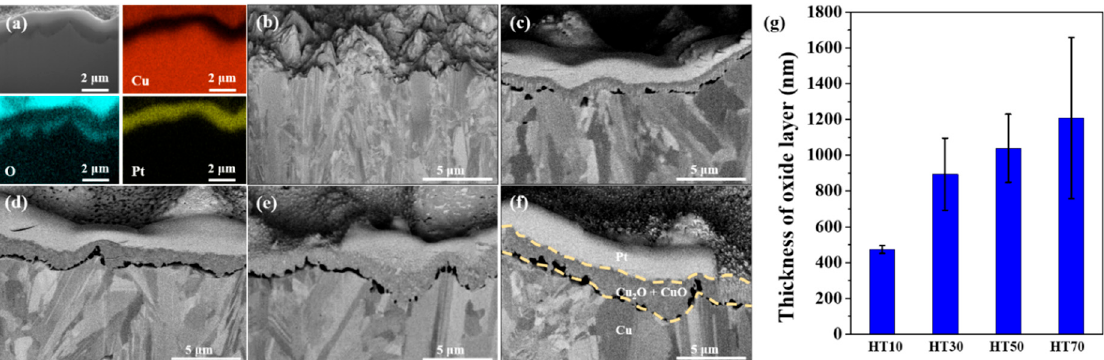
Figure 2. ( a ) EDS mapping of electrodeposited copper layer with heat treatment for 70 min (HT70). Cross-sectional SEM image of ( b ) electrodeposited copper layer (CS), and electrodeposited copper layer with heat treatment for ( c ) 10 min (HT10), ( d ) 30 min (HT30), ( e ) 50 min (HT50), and ( f ) 70 min (HT70). ( g ) Thickness of oxide layer formed by heat treatment.